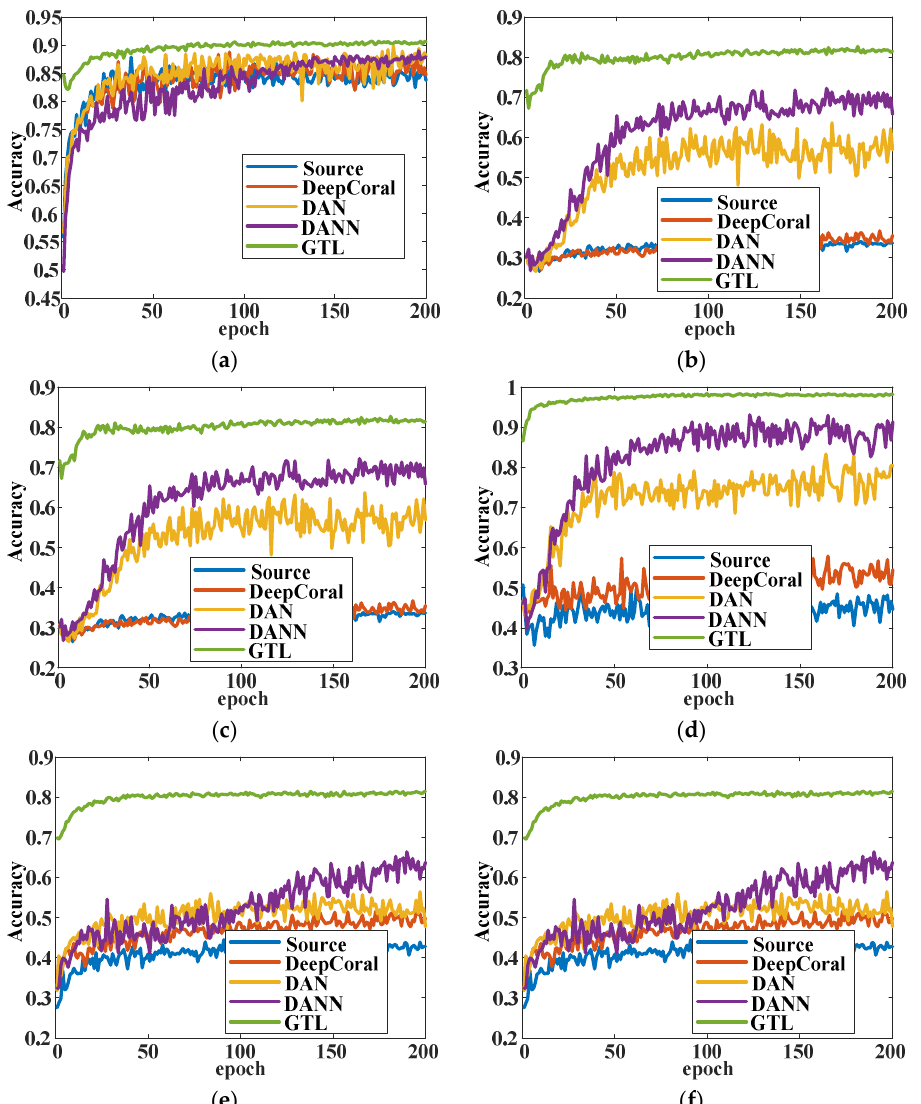
Figure 7. The changes of accuracy with epoch at six transfer tasks: ( a ) H → M; ( b ) H → L; ( c ) M → H; ( d ) M → L; ( e ) L → H; ( f ) L → M.